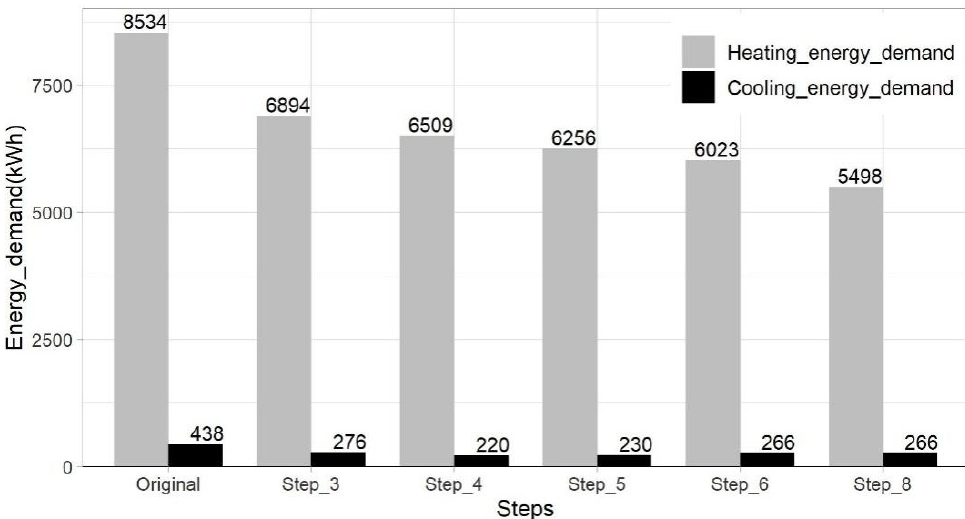
Figure 14. Annual heating and cooling energy demand according to each selected passive design.